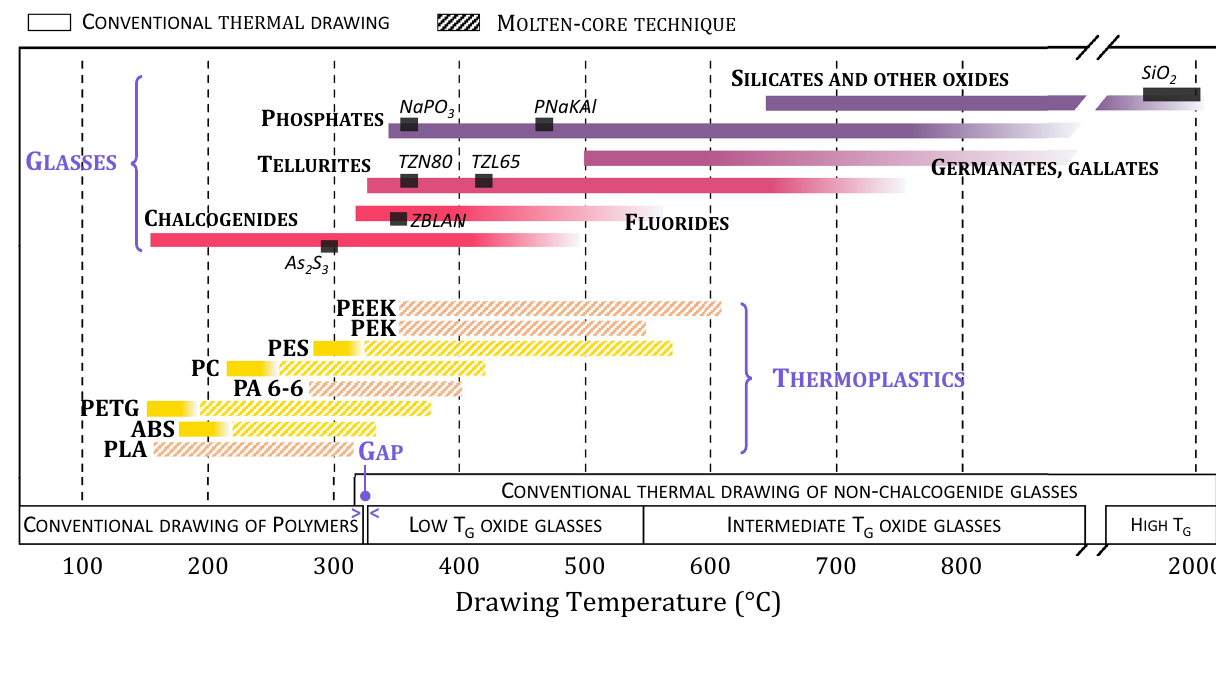
Figure 2. Drawing temperature ranges of various amorphous and semi-crystalline thermoplastics and glass materials using the conventional fiber-drawing method (open rectangle) or the molten core (shaded rectangle) method (see Table 1 for polymer acronyms). Drawing temperature ranges of known glass compositions (SiO 2 , As 2 S 3 , NaPO 3 and ZBLAN) and glasses investigated in the present work (TZN80, TZL65 and PNaKAl, see Table 3 for compositions) are shown on this figure (filled rectangle). Conventional drawing temperature domains of different classes of materials (amorphous polymers, low, intermediate and high T g glasses) are also shown on the bottom part of the graph. It is interesting to note that the drawing temperature domains of amorphous polymers and low T g oxide glasses do not